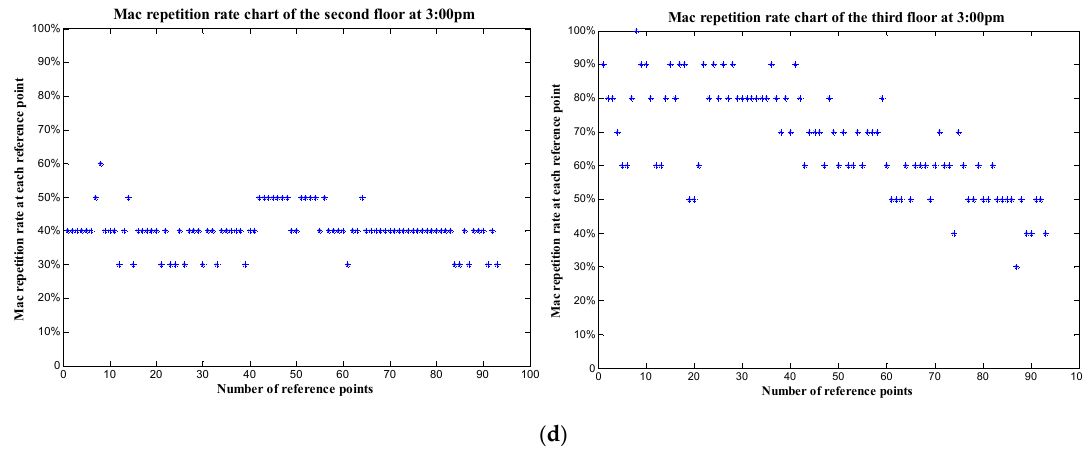
Figure 21. Comparison of MAC repetition rate chart of the second floor and that of the third one: ( a ) at 8:30 am; ( b ) at 9:00 am; ( c ) at 2:30 pm; ( d ) at 3:00 pm.